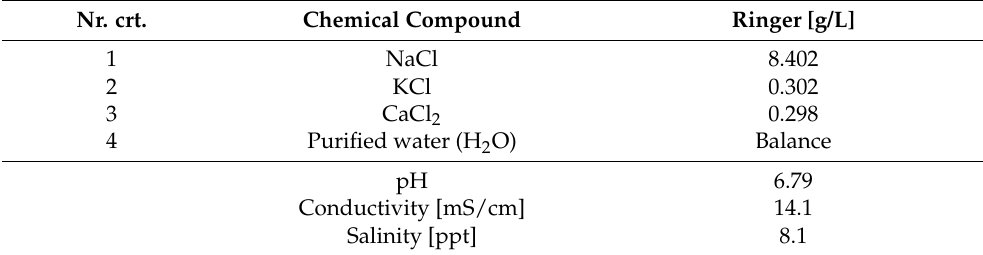
Table 2. Chemical composition and physical-chemical parameters for Ringer’s solution. Nr.